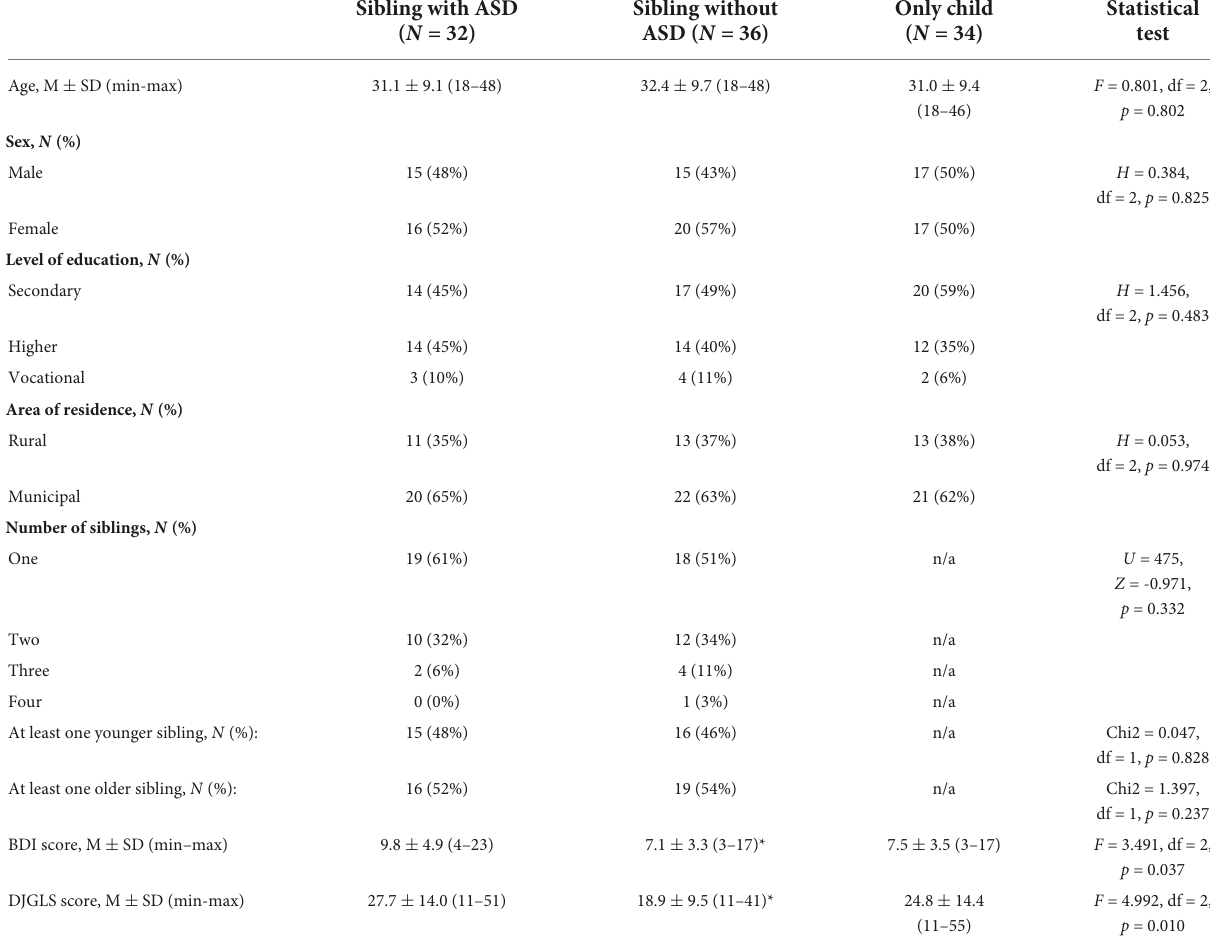
TABLE 1 Comparison of the characteristics of the studied group of adults, who have a sibling with autism spectrum disorder (ASD), siblings without ASD and were the only child.